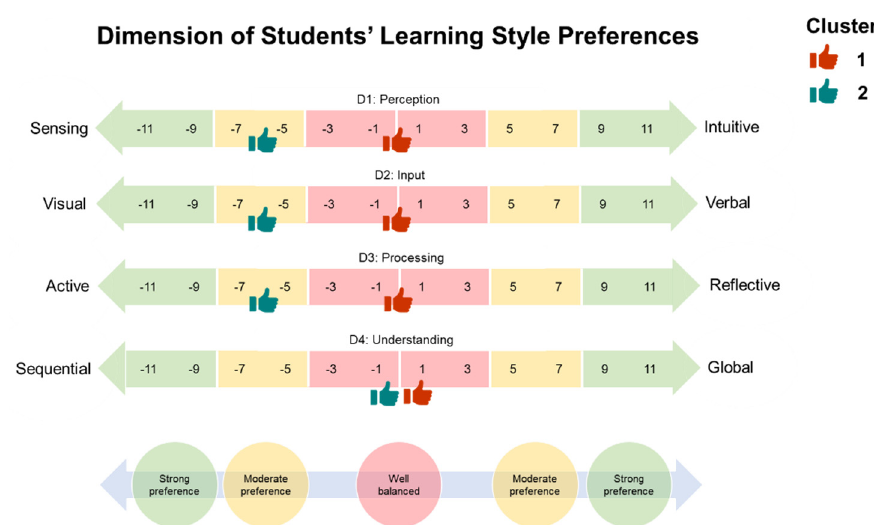
Figure 3. Clusters and learning styles.